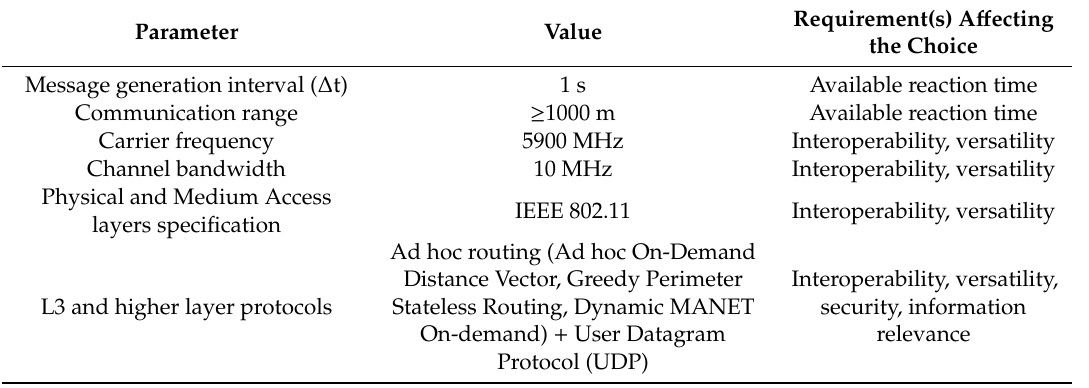
Summary of the privacy ensuring emergency vehicle approaching warning system (PEEV-WS)